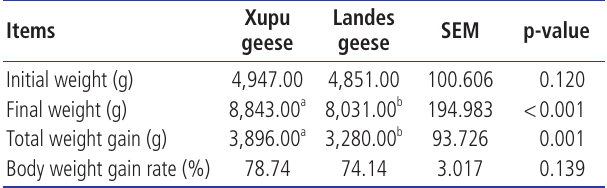
Table 2. Comparison of performance parameters between overfed Xupu and Landes geese Items